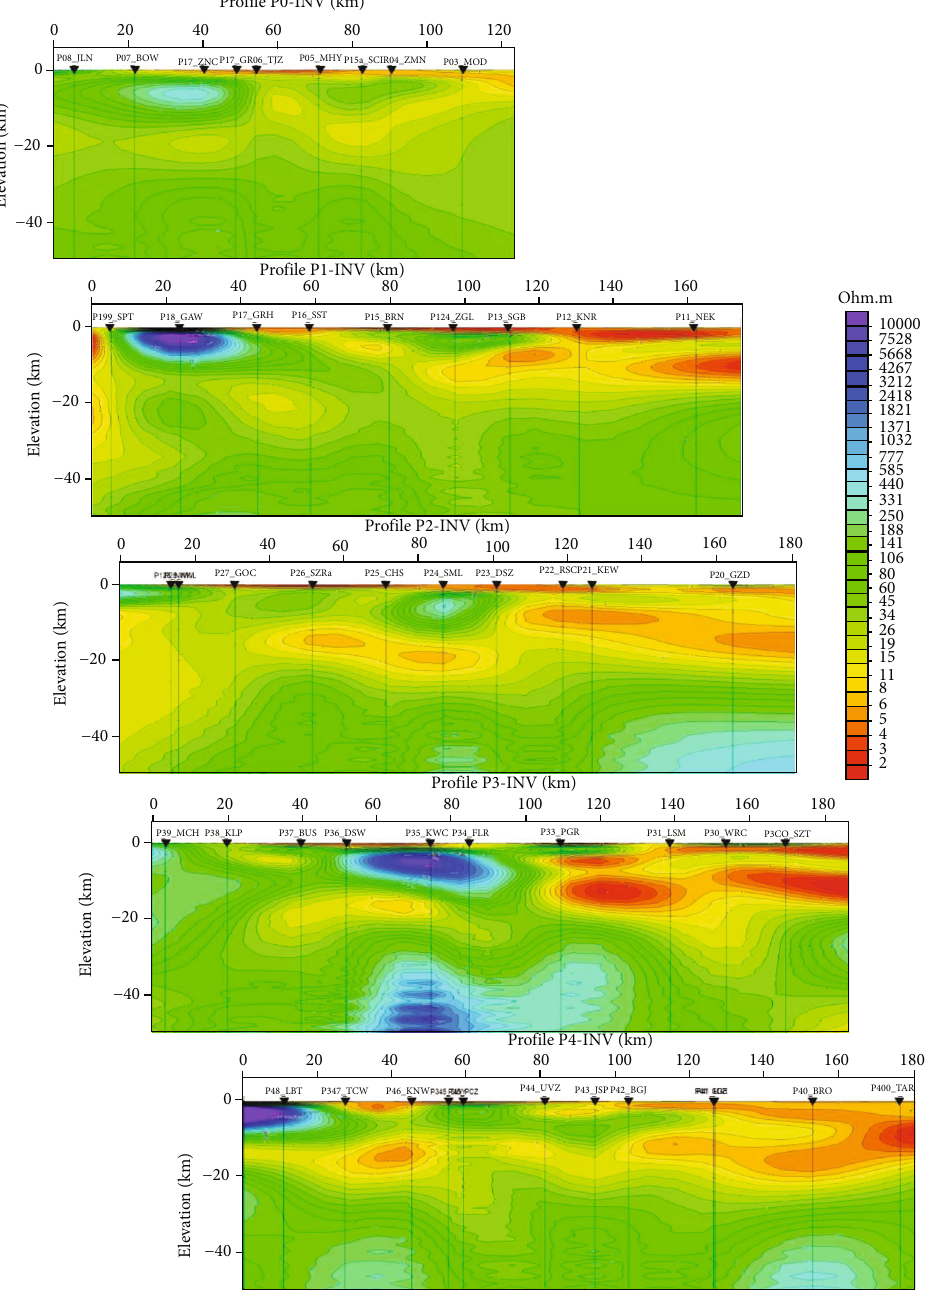
Figure 8: Comparison of cross-sections of the resistivity distribution for 1D smooth